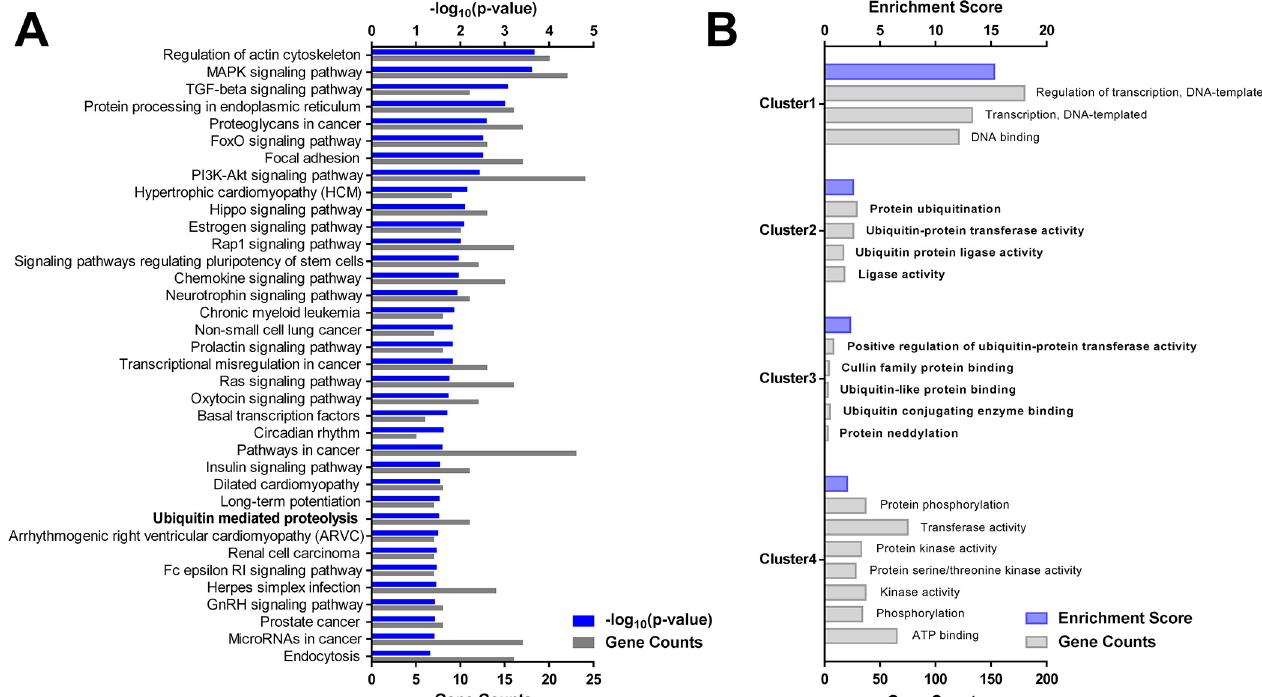
Fig 2. Functional annotation clustering of GO terms and KEGG pathways from the genes targeted by the ketamine-responsive prefrontal miRNAs. (A) KEGG pathways with p-values under 0.05 are displayed. The vertical axis represents the pathway categories, the upper horizontal axis represents -log 10 (p-value) value of each pathway, and the lower horizontal axis represents the number of genes involved in each pathway. (B) Functional annotation clusters with Enrichment Scores over 2 are displayed. The vertical axis represents the GO terms grouped into four clusters, the upper horizontal axis represents enrichment score values of each GO term, and the lower horizontal axis represents the number of genes included in each GO